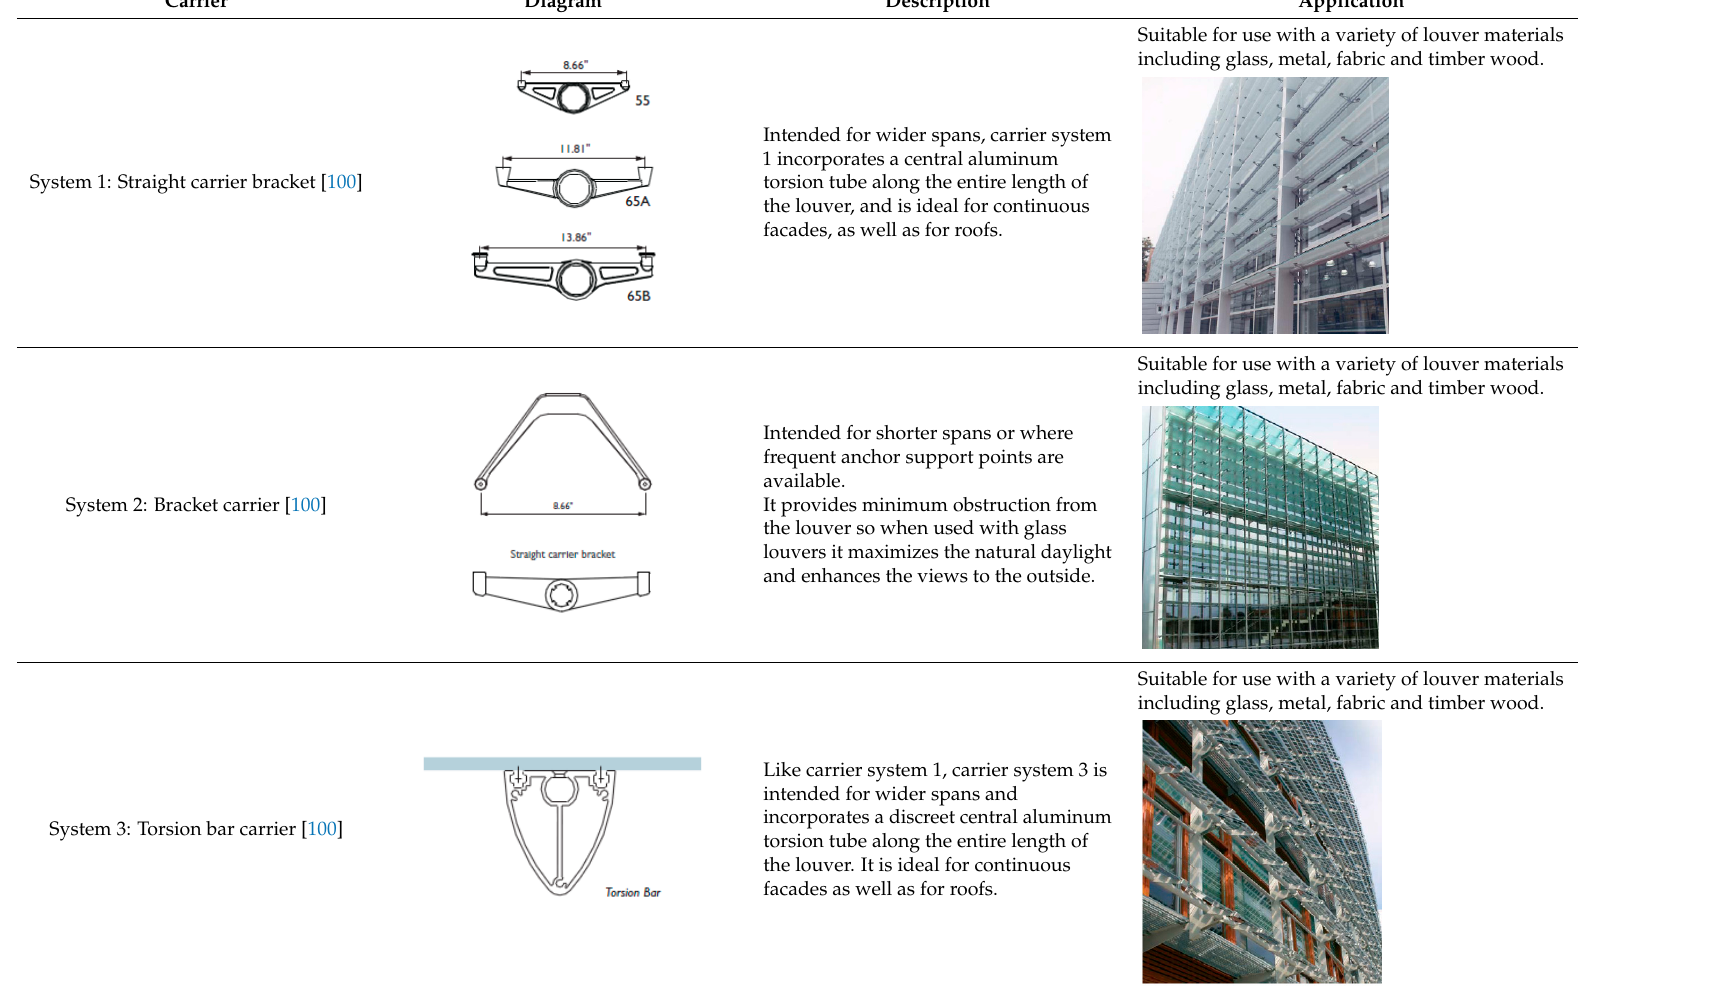
Table 4. Carrier systems of shading device.